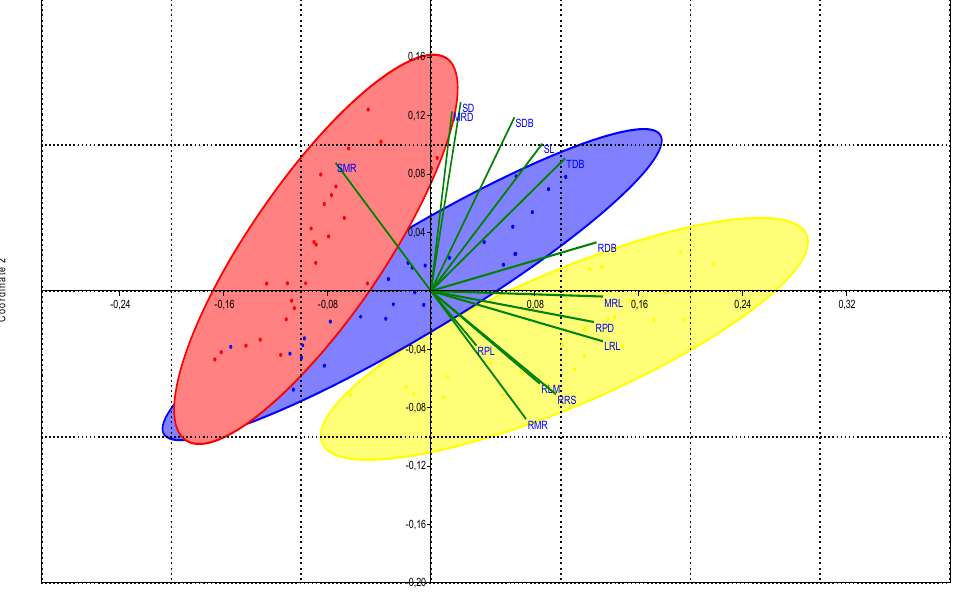
Figure 11. nMDS analysis of the main indicators of the maple seedlings performances (SL: Stem length; SD: Stem diameter; MRL: Main root length; MRD: Main root diameter; LRL: Lateral root length; RP: Root penetration; SDB: Stem dry biomass; RDB: Root dry biomass; TDB: Total dry biomass; RLM: Ratio of lateral length to main root length; RMR: Root mass ratio; SMR: Stem mass ratio; RRS: Ratio of main root length to stem length; RPL: Ratio of root penetration to main root length), difference tested among the three areas (yellow: Area A; blue: Area B; red: Area C).